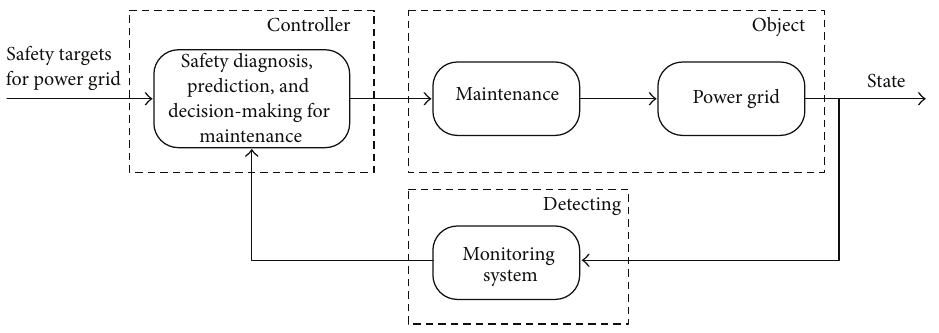
Figure 1: Maintenance based on safety status